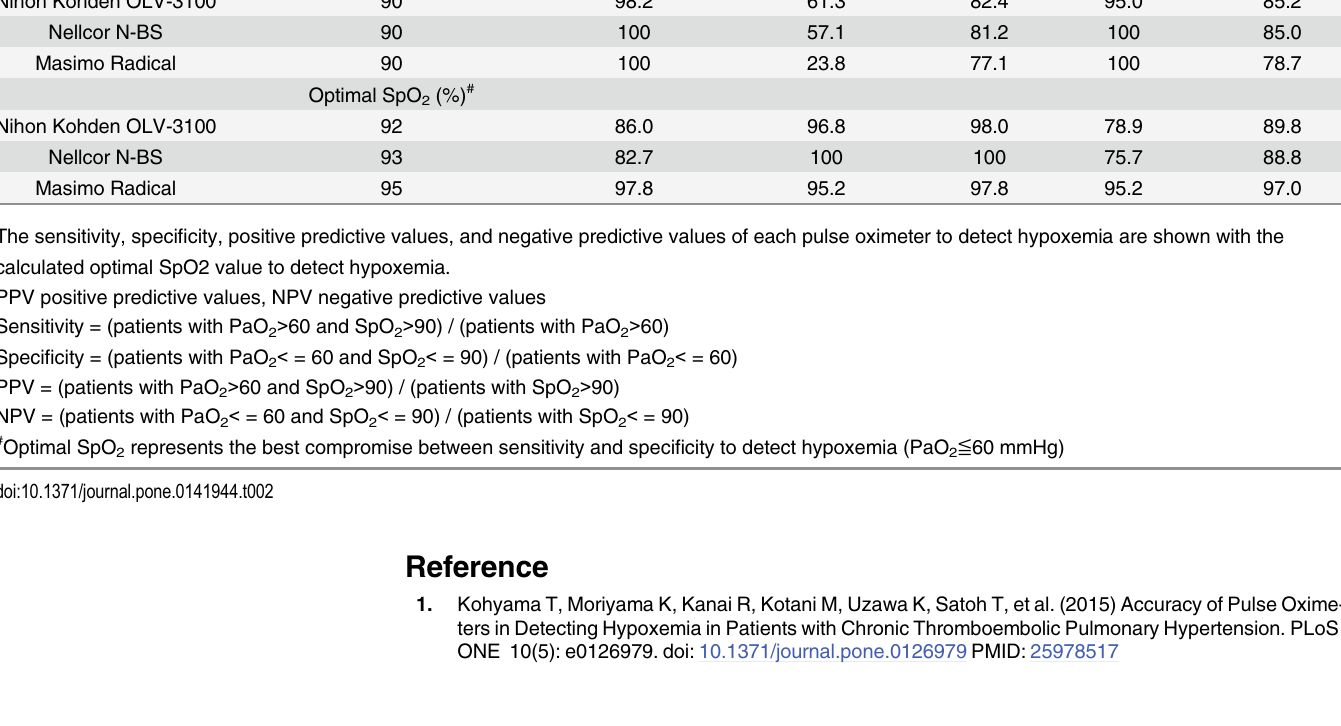
Table 6. Optimal SpO 2 value and ability of 3 pulse oximeters to detect hypoxemia (PaO2 ≦ 60 mmHg). Cut-off value of SpO 2 (%) Sensitivity